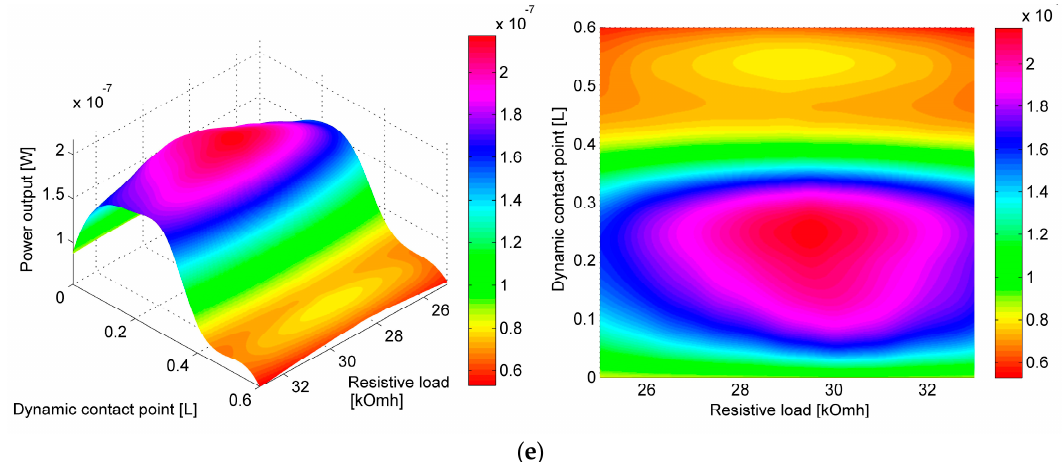
Figure 5. RMS Power output of PVEH with different resistive loads and dynamic contact point position. Isometric and top view with natural frequency ratio (cid:2033) (cid:2869)(cid:3017)(cid:3023)(cid:3006)(cid:3009) /(cid:2033) (cid:2869)(cid:3013)(cid:3007)(cid:3019) = ( a ) 8; ( b ) 6; ( c ) 4; ( d ) 3; ( e ) 2.